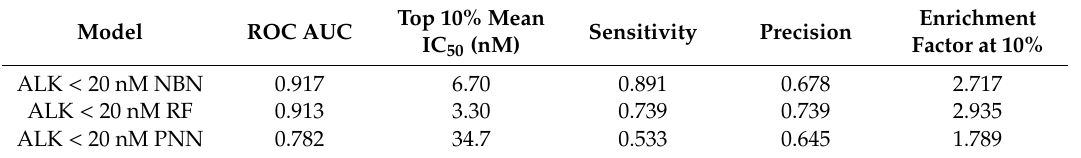
Table 2. Summary of performance for the NBN, RF, and PNN on the ALK dataset.